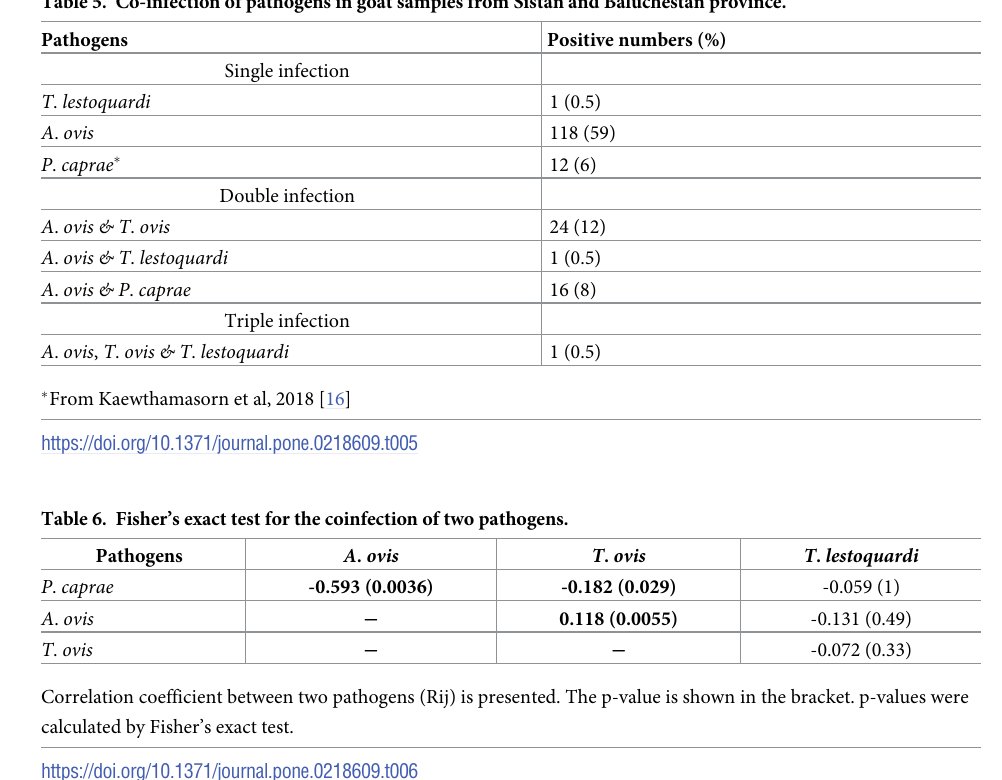
Correlation coefficient between two pathogens (Rij) is presented. The p-value is shown in the bracket. p-values were calculated by Fisher’s exact